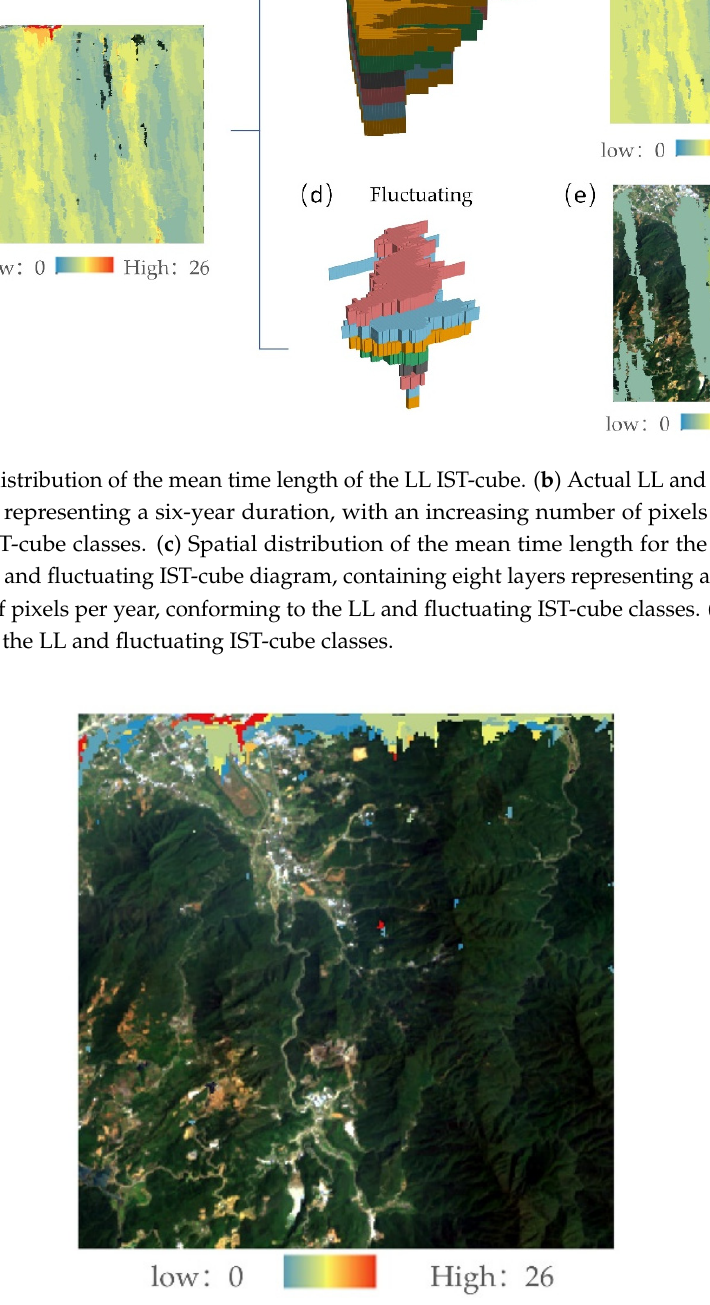
Figure 9. Spatial distribution map of LL IST-cube cube-core.